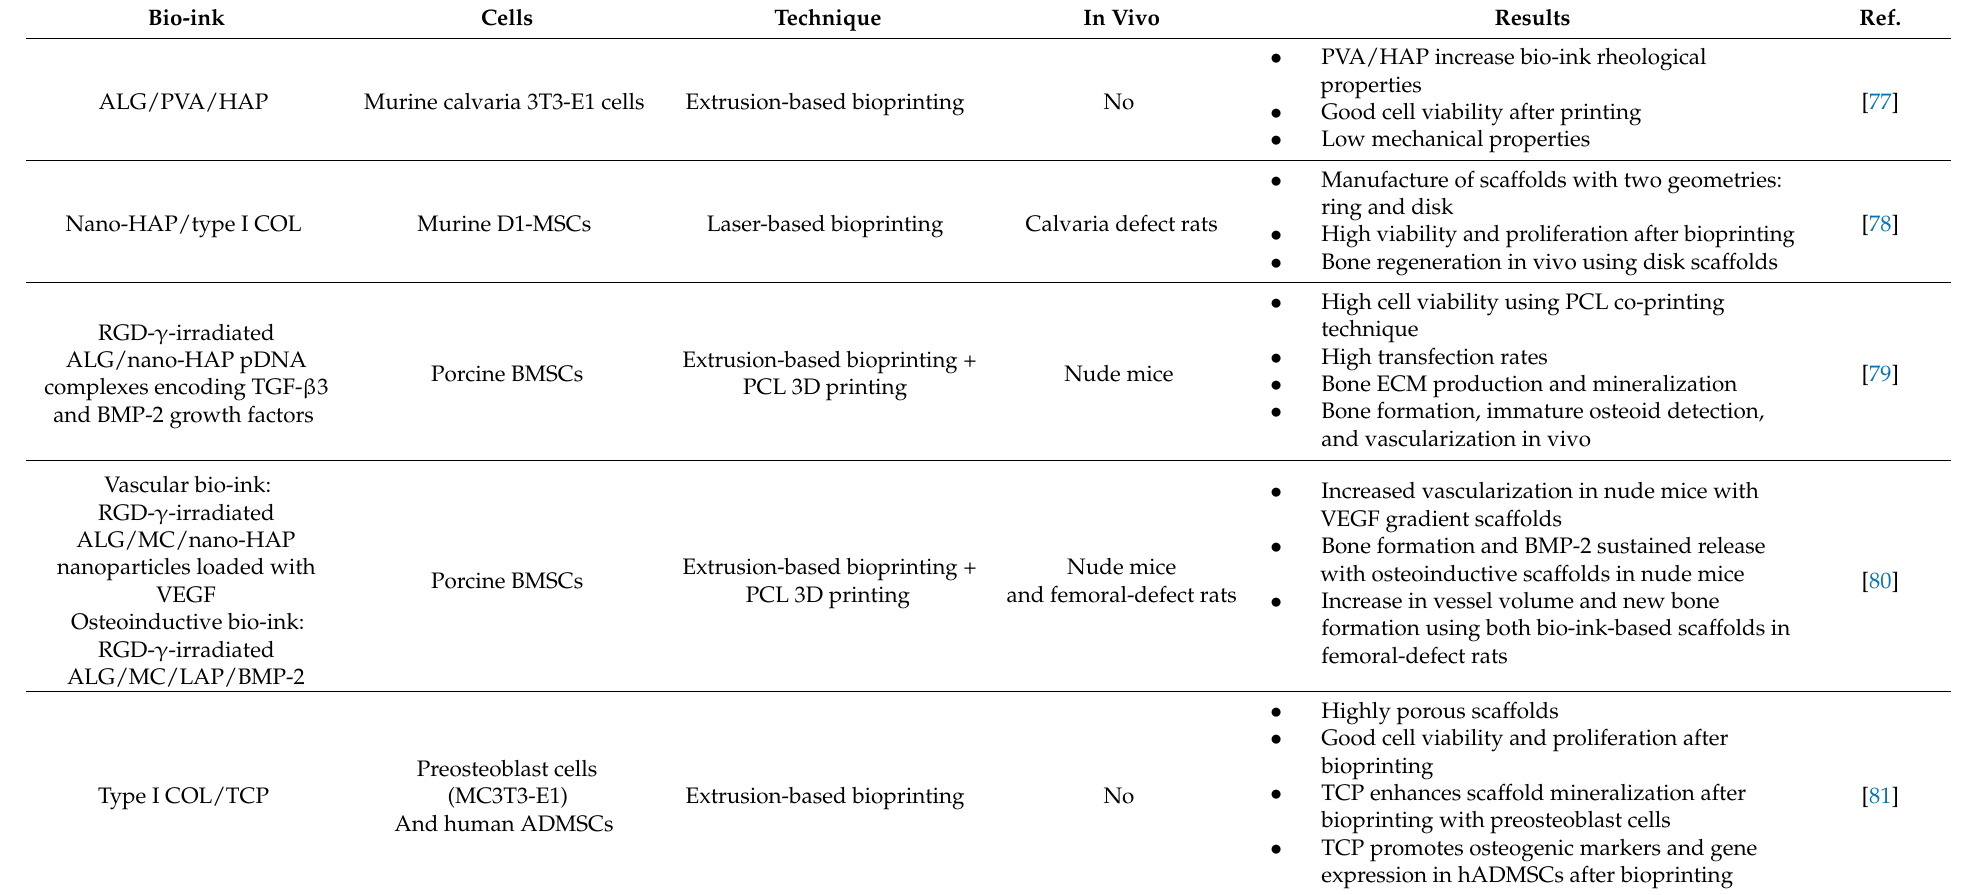
Table 3. Summary of the 3D bioprinting studies for bone